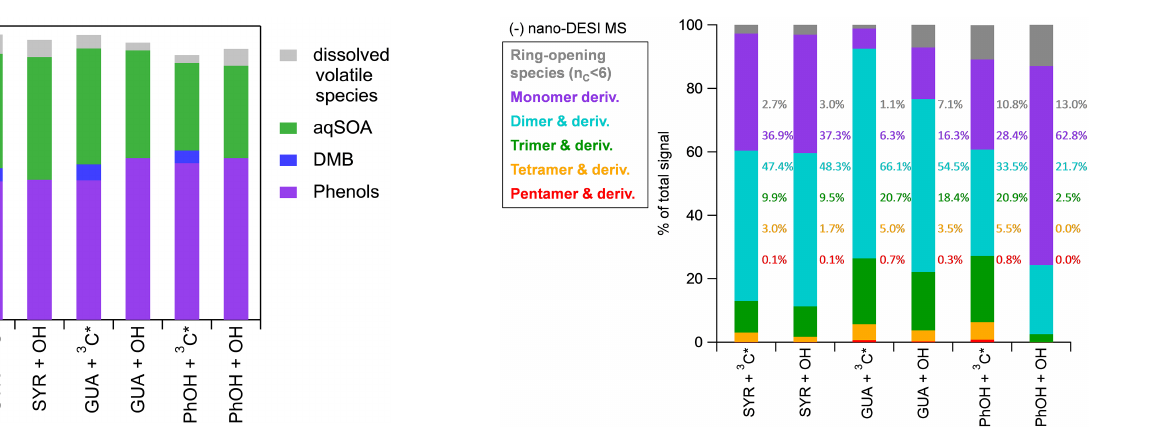
Figure 5. The signal-weighted distributions of syringol (SYR), gua- iacol (GUA), and phenol (PhOH) aqSOA formed in 3 C ∗ -mediated and · OH-mediated reactions, respectively, based on the degree of oligomerization. The data are from the (–) nano-DESI MS spectra. Note that hexamer and derivatives are only found in ( + ) nano-DESI MS spectrum for GUA aqSOA initiated with 3 C ∗ and (–) nano- DESI MS spectrum for PhOH aqSOA initiated with 3 C ∗ . The num- bers indicate the contributions of individual categories to the total signals for each